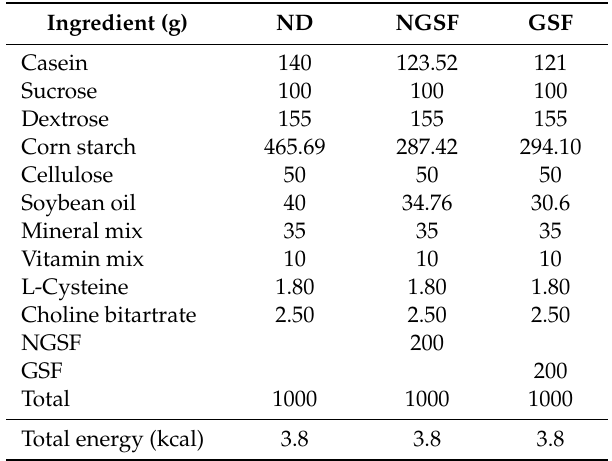
Table 2. Diet compositions of animal